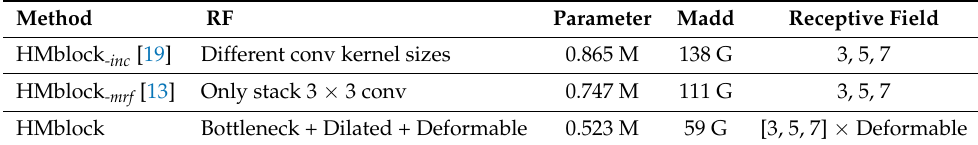
Table 2. Comparing different local multi-scale implementation methods.